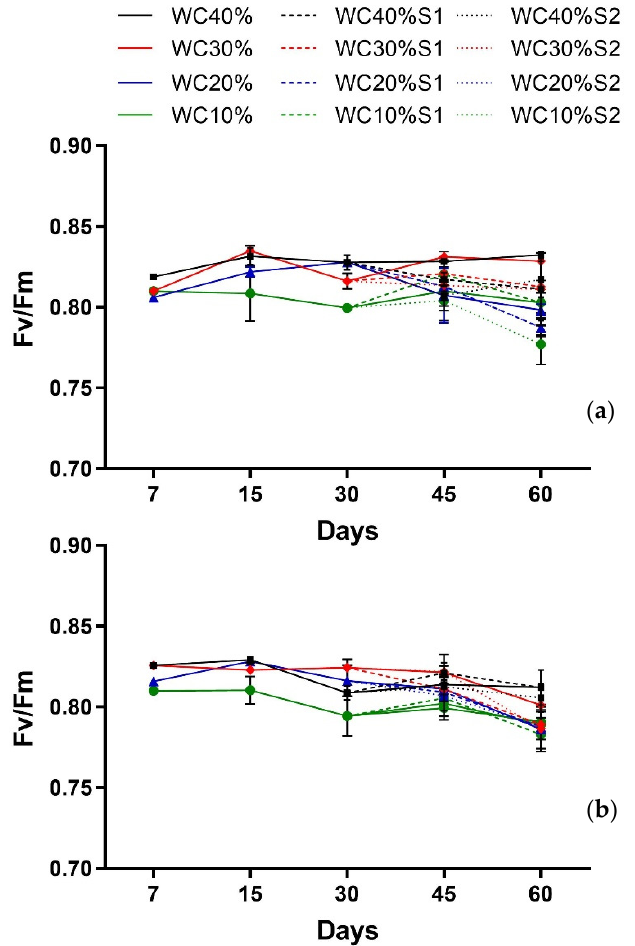
Figure 6. Trend of maximum quantum efficiency of PSII (Fv/Fm) in plants of Callistemon ( a ) and Viburnum ( b ) subjected to drought (WC 40%: control; WC 30%: light drought stress; WC 20%: moderate drought stress; WC 10% severe drought stress) and saline aerosol treatment (S0: Distilled water, S1: 50% Synthetic seawater solution, S2: 100% Synthetic seawater solution). Data are means ± standard error ( n = 3). Three biological replicates were used for the